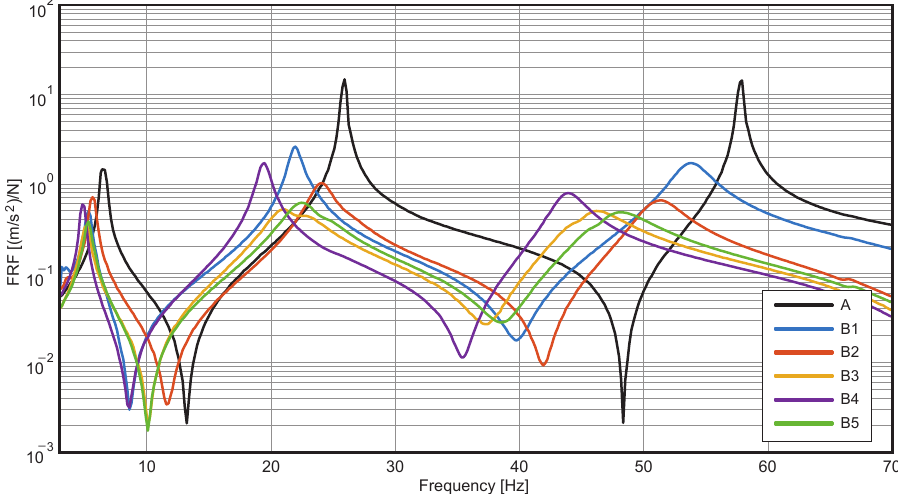
Figure 9. FRF of the reference beam (A) and configurations with uniform constraining layer